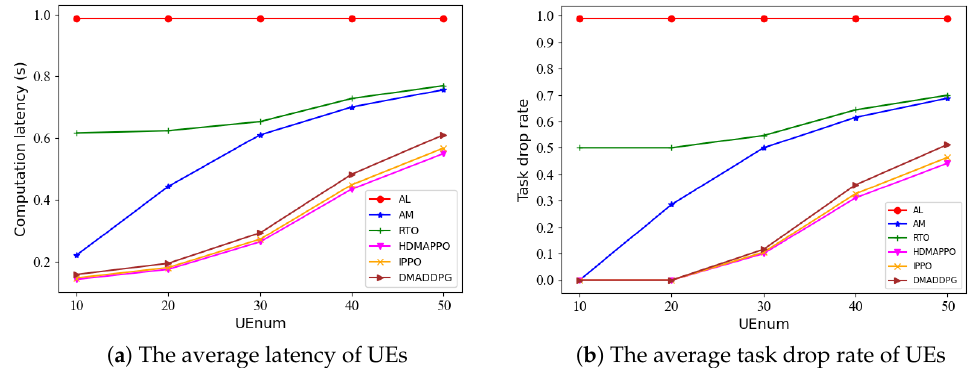
Figure 4. Impact of the number of UEs on the average task latency and task drop rate.